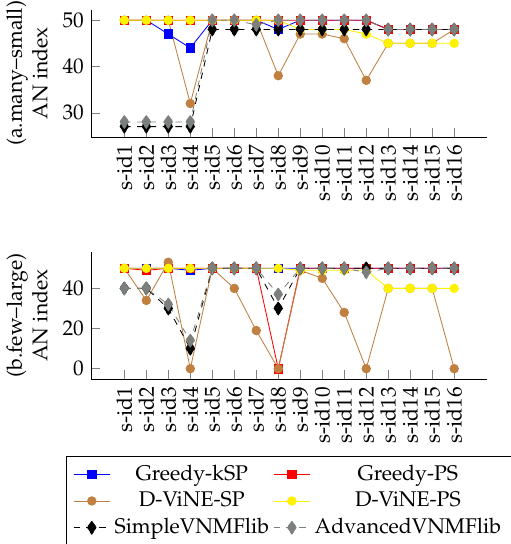
Figure 7. Active nodes of the examined embedding